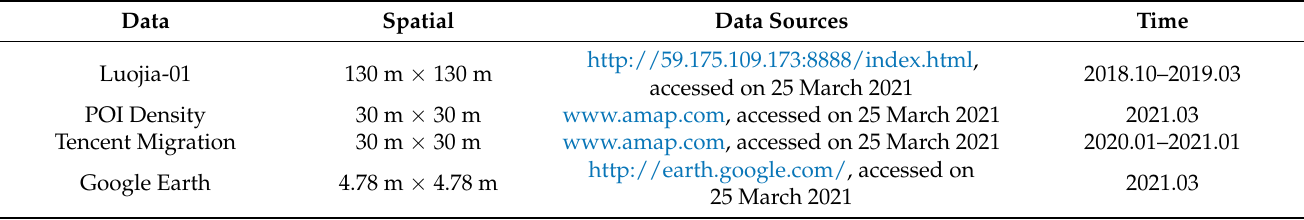
Table 1. The proportion of the 22 kinds of POI data in Guangdong–Hong Kong–Macao Greater Bay Area during 2021. Data